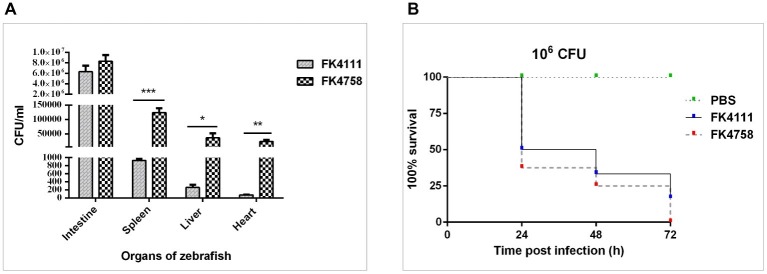
Assessment of bacterial burden of organs after intestinal colonization and analysis of the virulence of FK4111 and FK4758. (A) CFUs of bacteria cultured from the intestines, spleens, livers, and hearts of zebrafish exposed to FK4111 and FK4758 by immersion experiments. Data shown are the average CFUs cultured from 10 fish in each of the groups. *, **, and ***Represent p < 0.05, p < 0.01, and p < 0.001, respectively; (B) differences in the virulence of FK4111 and FK4758, established by the Galleria mellonella infection model.